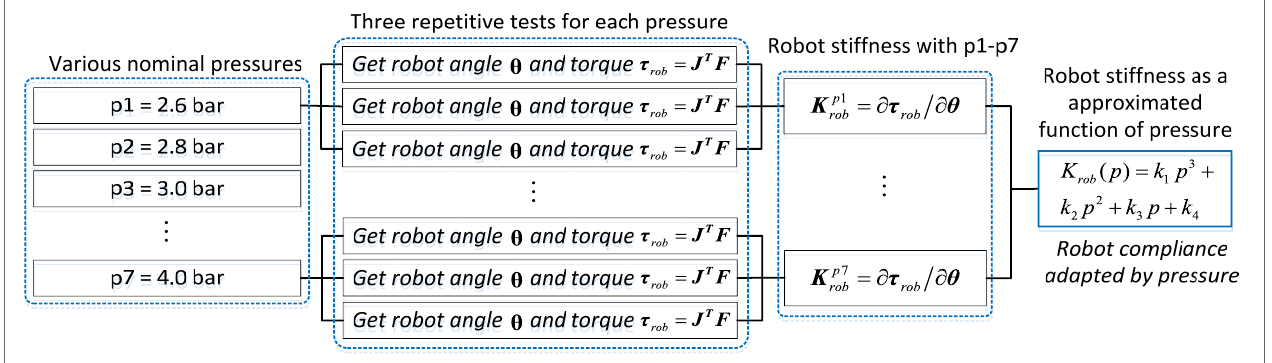
FIGURE 3 | Diagram of the robot compliance modeling estimation and adaptation